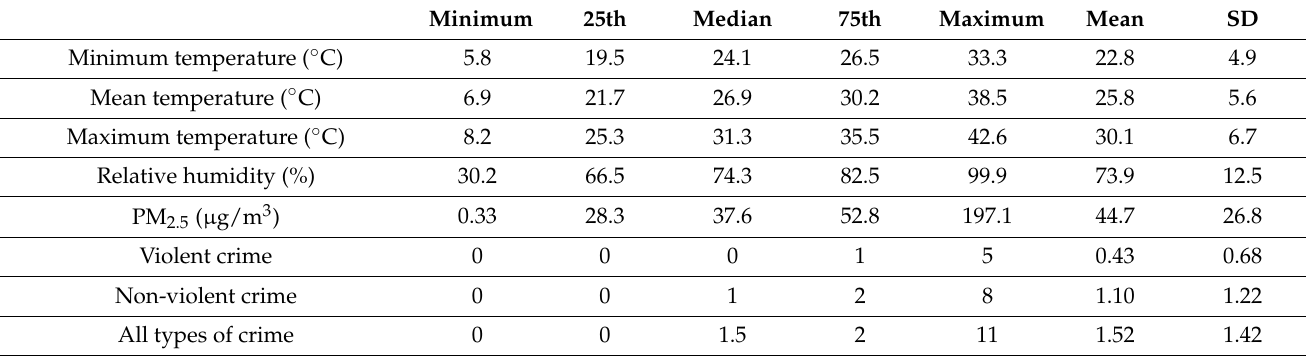
Table 1. Daily weather conditions and crime occurrence by type in urban Hanoi, Vietnam, 2013–2019.